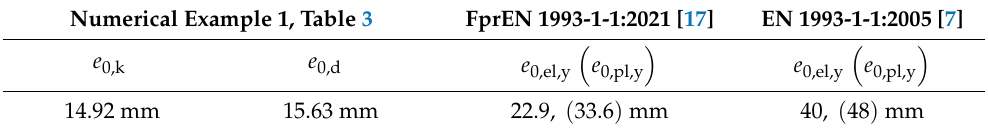
Table 8. Buckling about axis y − y . Comparison of bow imperfections e 0 for the second-order theory. Numerical Example 1, Table 3